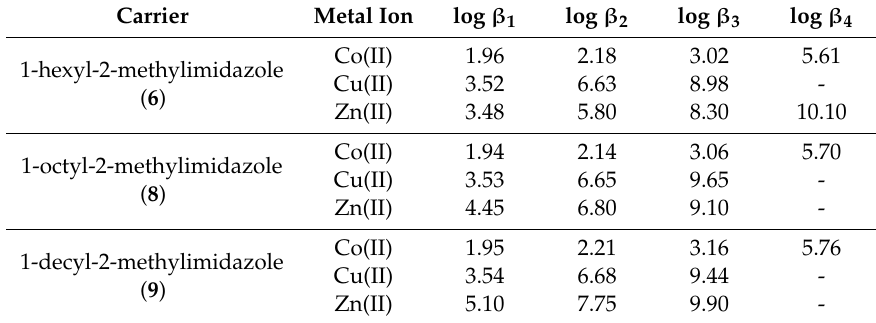
Table 3. The stability constants (log β n ) of Co(II) [41], Cu(II) [40], and Zn(II) [40] complexes with